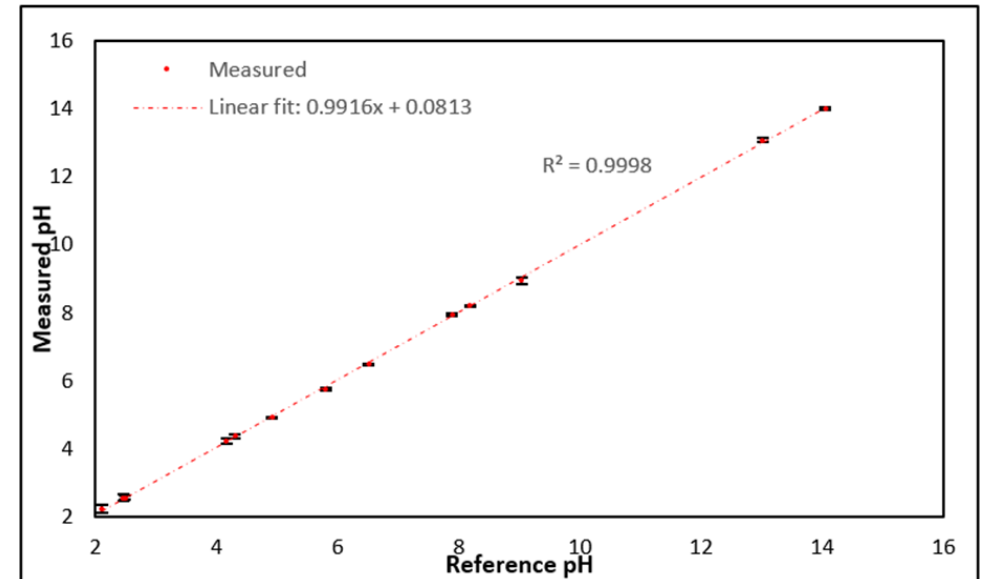
Figure 7. The performance of the portable instrumentation for pH measurements is established by comparing our results to those of a reference instrument (Ohaus, AB33M1). The solutions utilized for this experiment, in ascending order of pH value, commencing from the most acidic one, are given as follows: a. Lemon juice, b. Cola soda, c. Vinegar, d. Orange juice, e. Beer, f. Coffee, g. Tea, h. Milk, i.